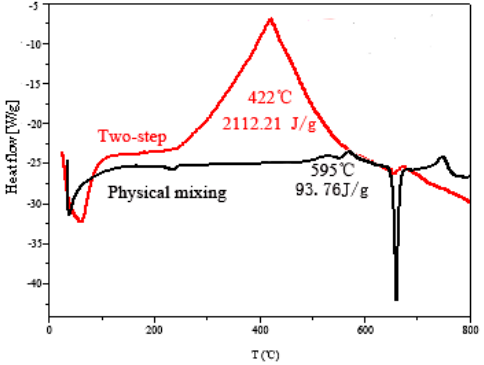
Figure 6. Comparison of DSC curves for different samples.